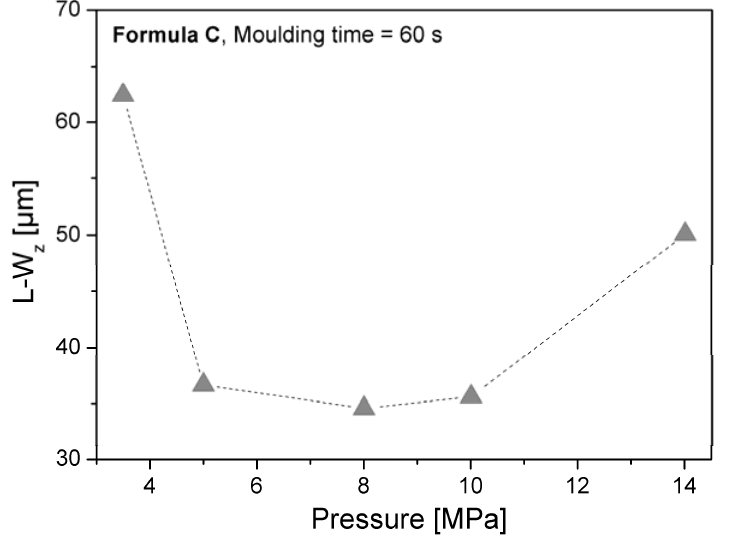
= 100 mm and Δ = 100 m x